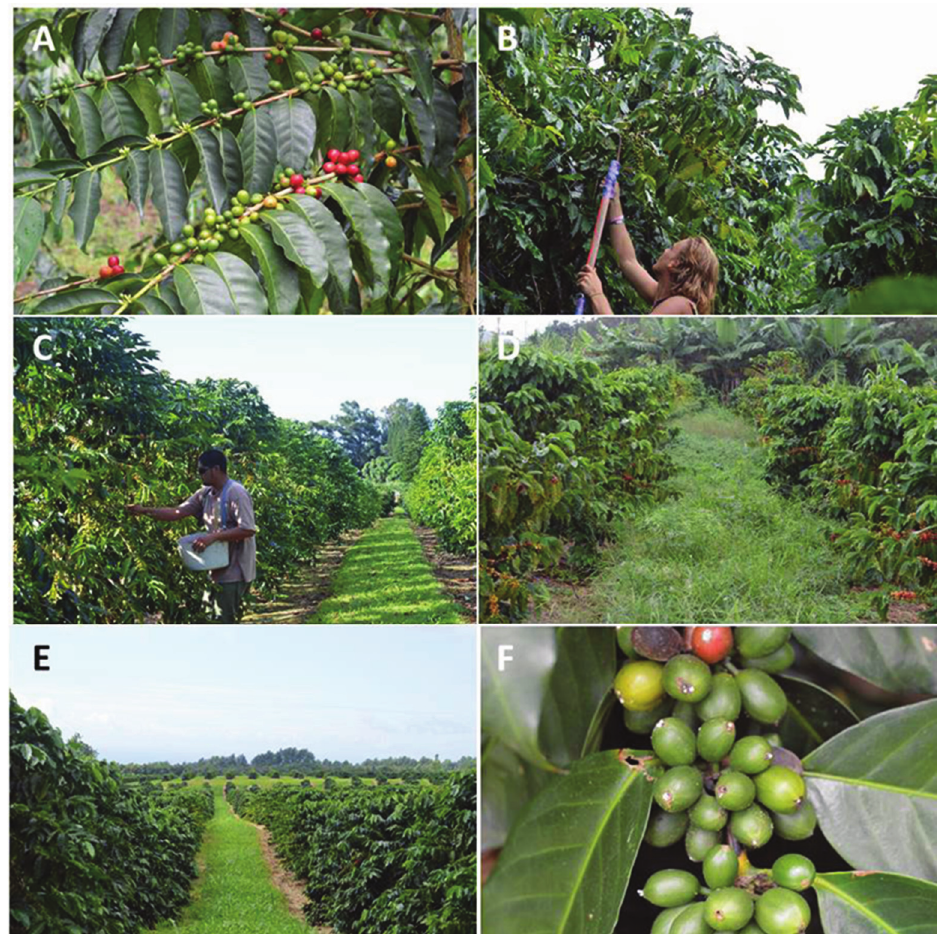
Figure 4. Coffee tree with berries at developmental stages from flowering to maturity ( A ); tall trees with many verticals and narrow spacing (<2 m) makes collection difficult ( B ); trees with <4 verticals and spacing >2 m simplifies harvest ( C ); weeds obscure fallen berries ( D ); weed management facilitate harvesting ( E ); CBB in AB position infected by B. bassiana ( F ); Photos taken in Pahala, Hawaii, by Libia C. Mahé, and Luis F. Aristizábal.